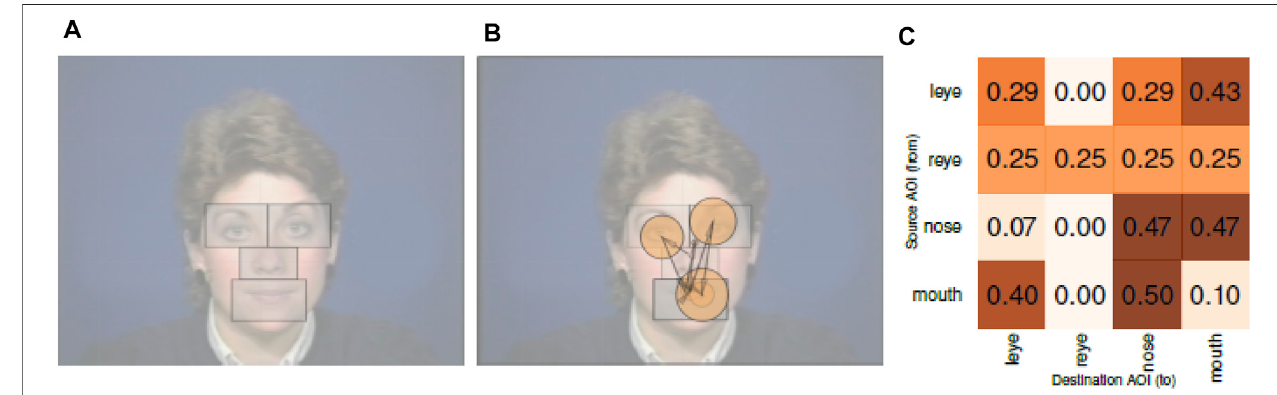
FIGURE 4 | AOIs, Scanpaths, and Gaze Transition Matrices from Jayawardena et al. (2020). (A) AOI on face stimuli. (B) Scanpath with fi xations on the AOIs. (C) Gaze transition matrix.